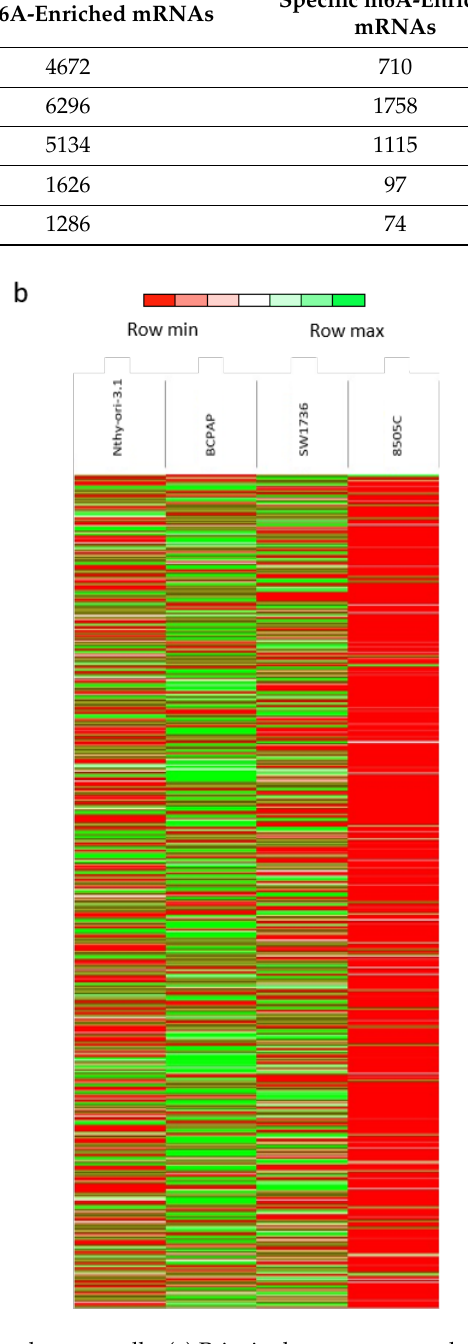
Figure 1. m6A patterns in thyroid normal and cancer cells. ( a ) Principal component analysis (PCA) results. Each point represents an meRIP-seq sample. Samples with similar gene expression profiles clustered together. ( b ) Heat maps showing the hierarchical clustering of m6A-enriched mRNAs in Nthy-ori-3.1, BCPAP, SW1736, and 8505C. Results are shown as fold change (log 2).